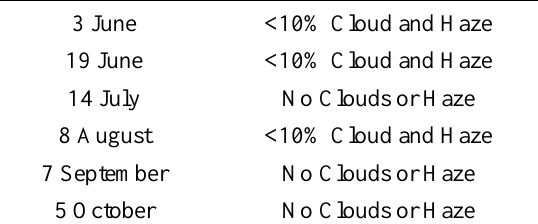
Table 1. MODIS imagery dates and estimated cloud